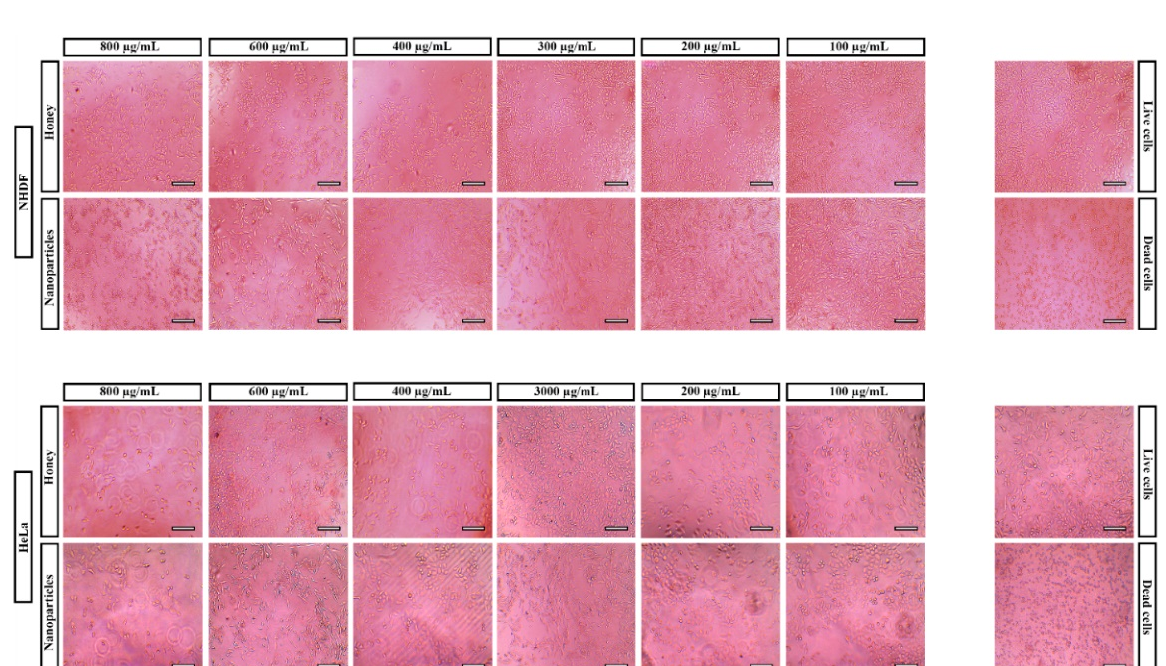
Figure 6. Microscopic images of NHDF and HeLa cells in contact with different concentrations of NPs and honey. Scale bar: 100 µm.